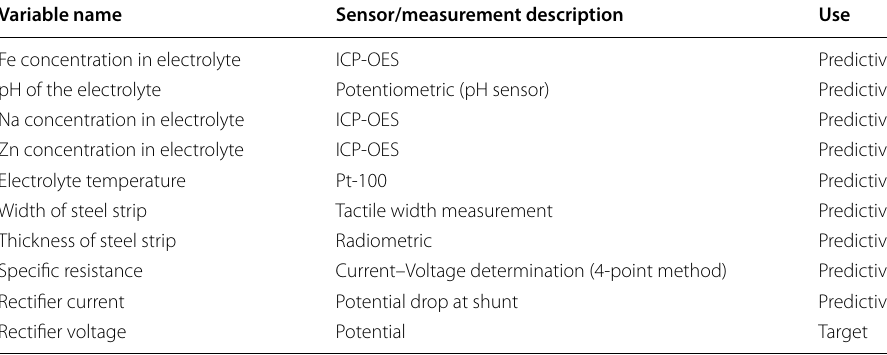
The variables are divided into three groups: electrolyte parameters, strip parameters, current characteristics. Out of these, nine parameters will be used as predictive